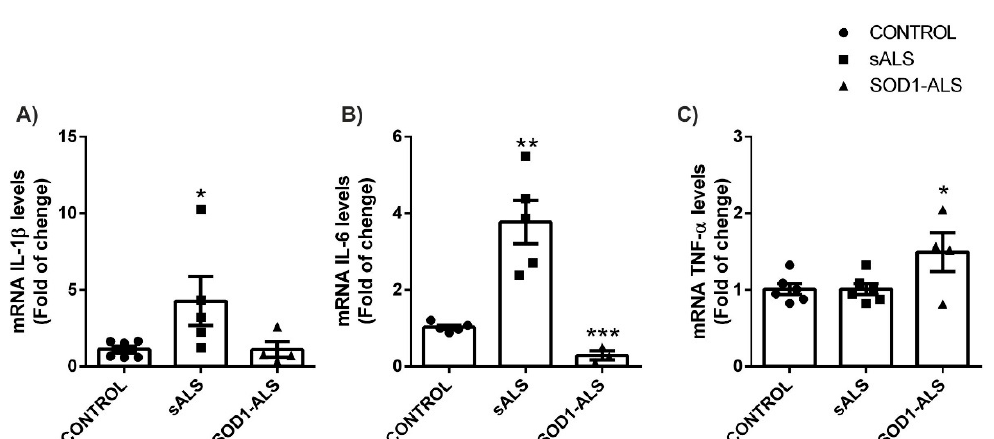
Figure 5. Increased IL-1 β and IL-6 levels mRNA expression levels in sALS and SOD1 -ALS lymphoblasts. Quantitative real-time PCR determination of messenger RNA levels of pro-inflammatory cytokines IL-1 β ( A ), IL-6 ( B ), and TNF ( C ), normalized by β -ACTIN messenger RNA levels. Dots indicate the mean of n = 6 (controls), n = 5–6 (sALS) and n = 4 ( SOD1 -ALS) samples ± SEM. Asterisks denote significant differences * p < 0.05 and ** p < 0.01, comparing the indicated groups with the basal condition according to a one-way ANOVA followed by Tukey post-test.